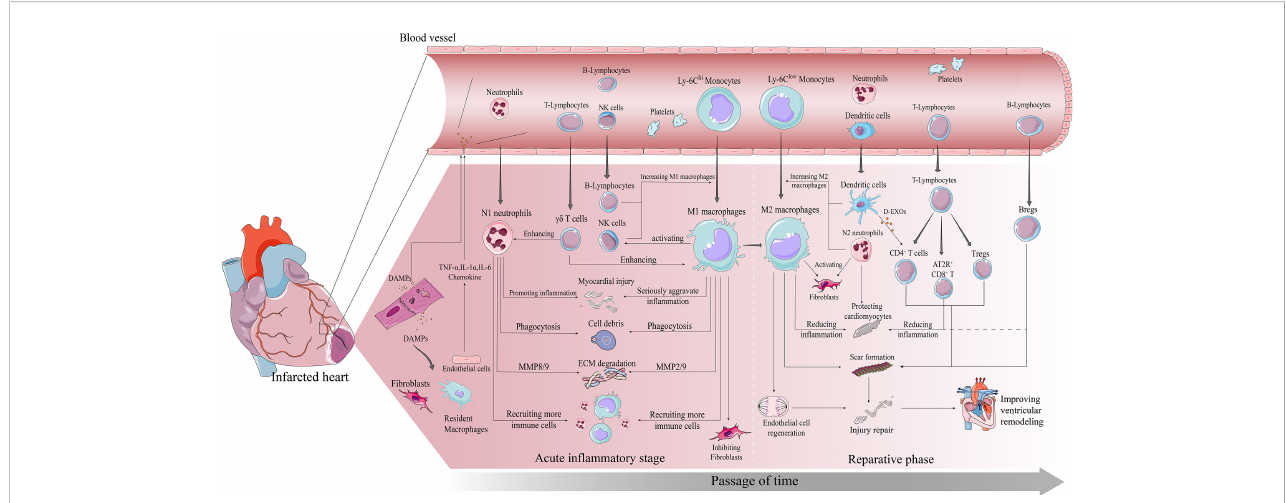
FIGURE 1 Immune cascade after MI. early post-MI necrotic cells release DAMPs which bind to surviving parenchymal cells releasing pro-in fl ammatory and chemokines and recruiting immune cells to in fi ltrate. The in fl ammatory phase is dominated by in fi ltration of Ly-6C hi monocytes, M1 macrophages and neutrophils. All three work together to degrade the ECM, phagocytose necrotic cells, and amplify the in fl ammatory response to recruit more pro- in fl ammatory immune cells. The repair phase focuses on resolution of in fl ammation and cardiac repair, with Ly-6C low monocytes, M2 macrophages, and Tregs in fi ltrating predominantly. All three work together to suppress in fl ammation, promote fi broblast activation involved in scar formation, and promote vascular regeneration, ultimately preventing further injury and improving ventricular remodeling in time.